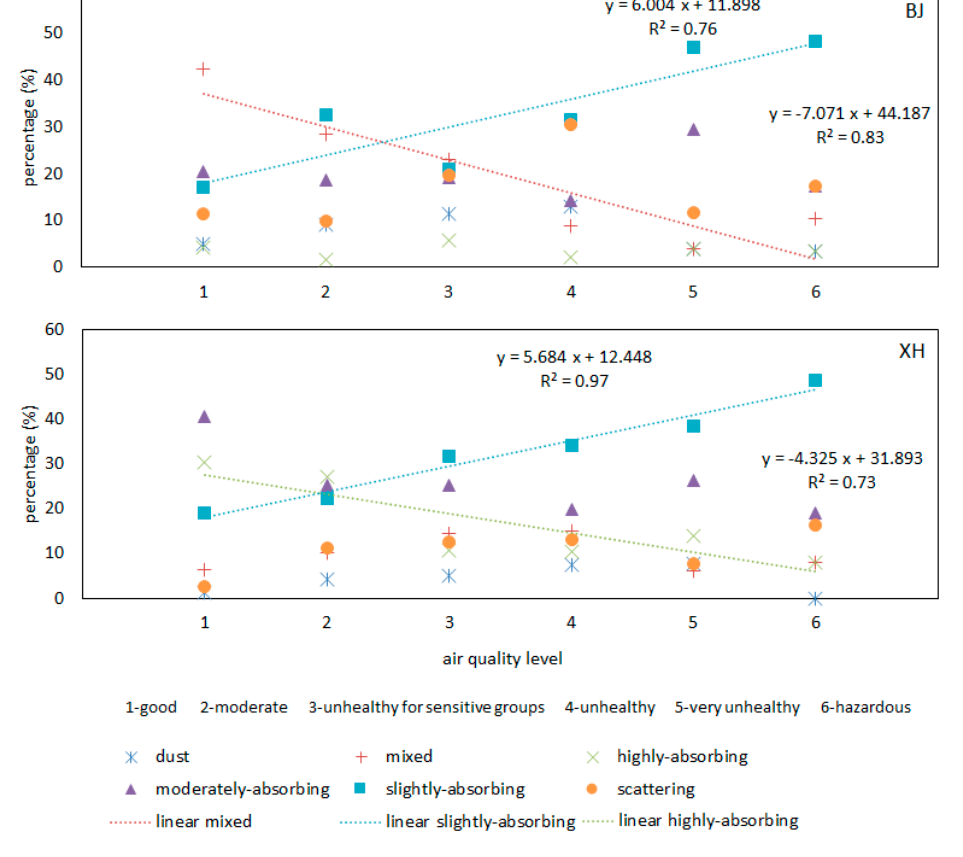
Figure 10. Linear regression of the air quality index (AQI) and the proportion of aerosol types at BJ and XH stations (2013–2015). and XH stations